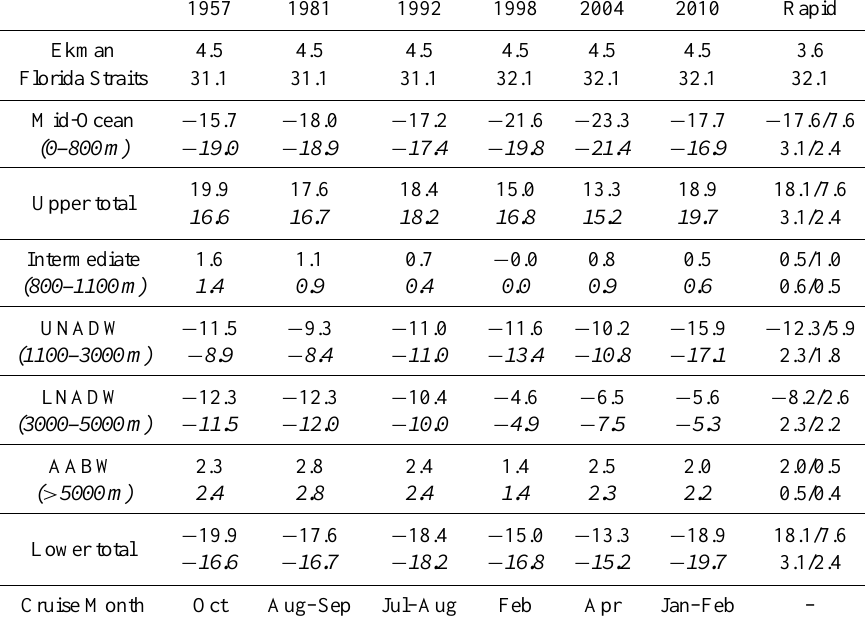
Table 5. Northward transport (Sv) in depth classes for the six hydrographic sections calculated using long-term mean Ekman and Florida Straits transports (thus, isolating interior ocean variability). Numbers in italic denote transports adjusted for seasonal variability derived from 5 years of Rapid-WATCH observations (2004–2009). Rapid-WATCH transports are also calculated using long-term mean Ekman and Florida Straits transports. For each depth class, Rapid-WATCH timeseries transport properties are given (right-most column), these are: mean transport/seasonal cycle range (upper), std. dev./std. dev. with seasonal cycle removed (lower). Depth class definitions are from Table